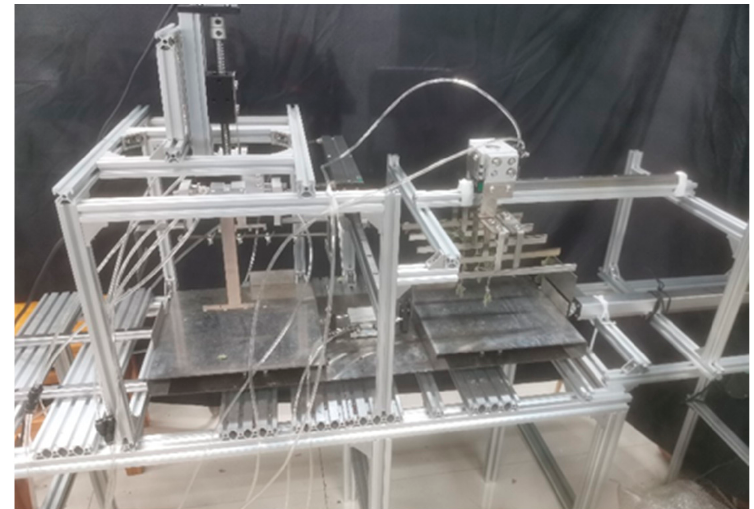
Figure 13. Whole-plate grafting test prototype.